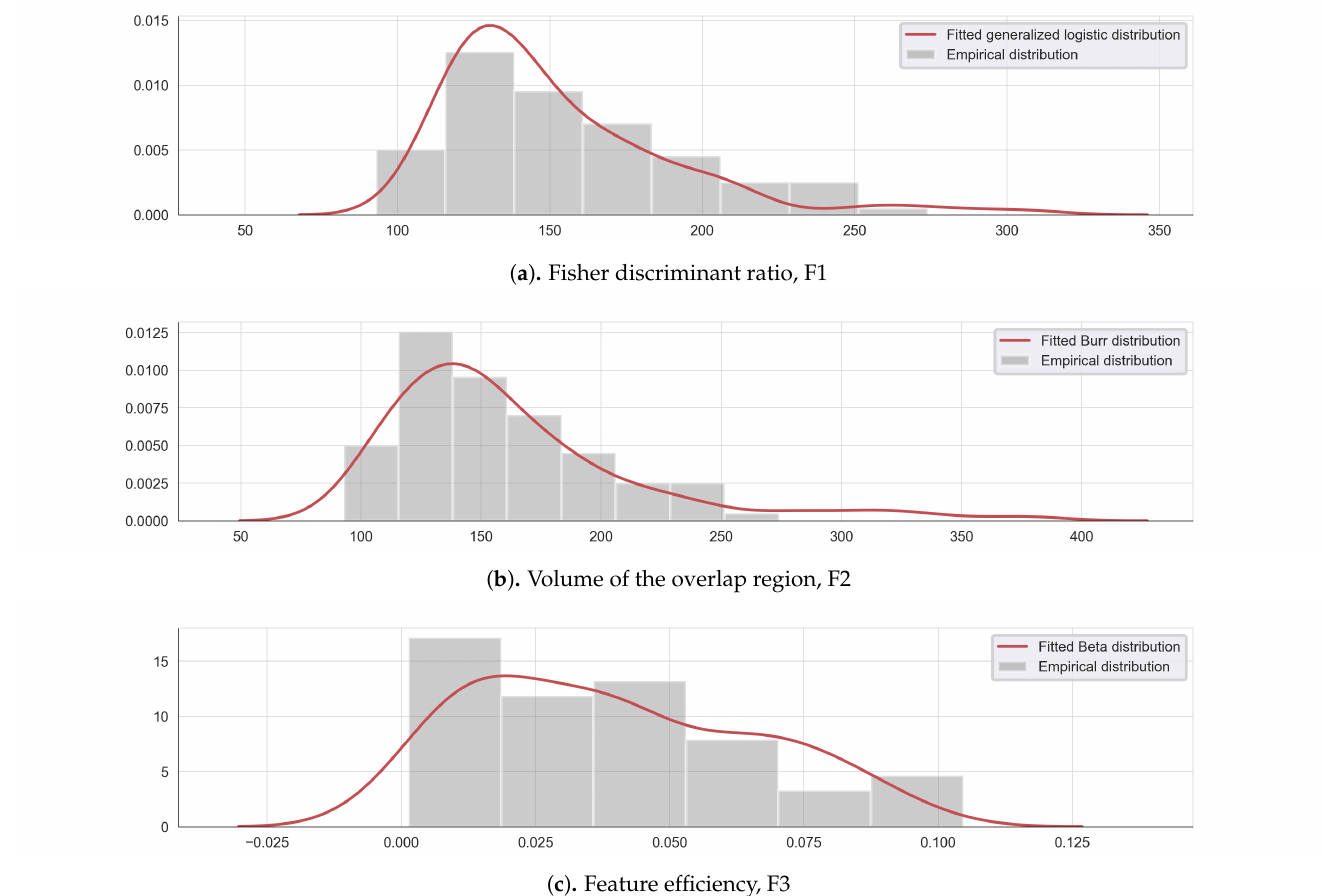
Figure 5. Empirical and fitted distribution for the complexity measures ( a ) Fisher discriminant ratio F1, ( b ) the volume of the overlap interval F2, and ( c ) the individual feature efficiency